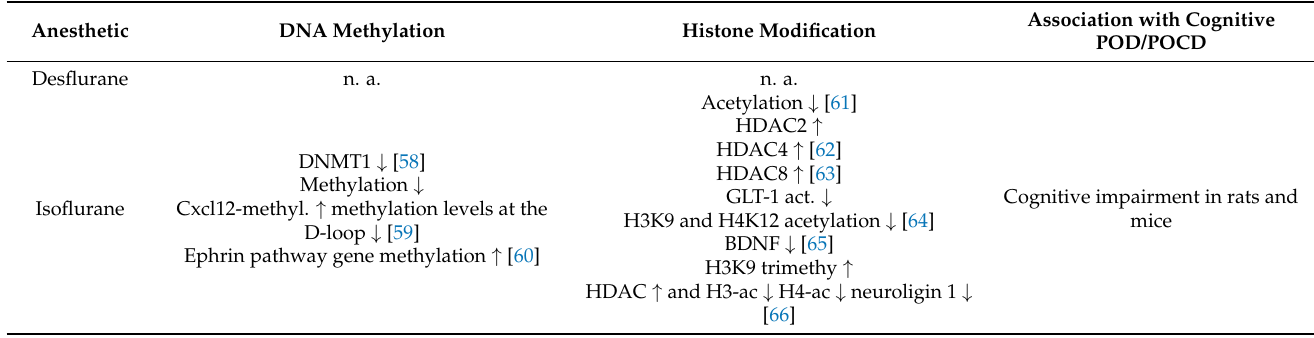
Table 1. Overview of epigenetic modifications caused by anesthetics and their possible impact on cognitive impairment (n.a. not analyzed so